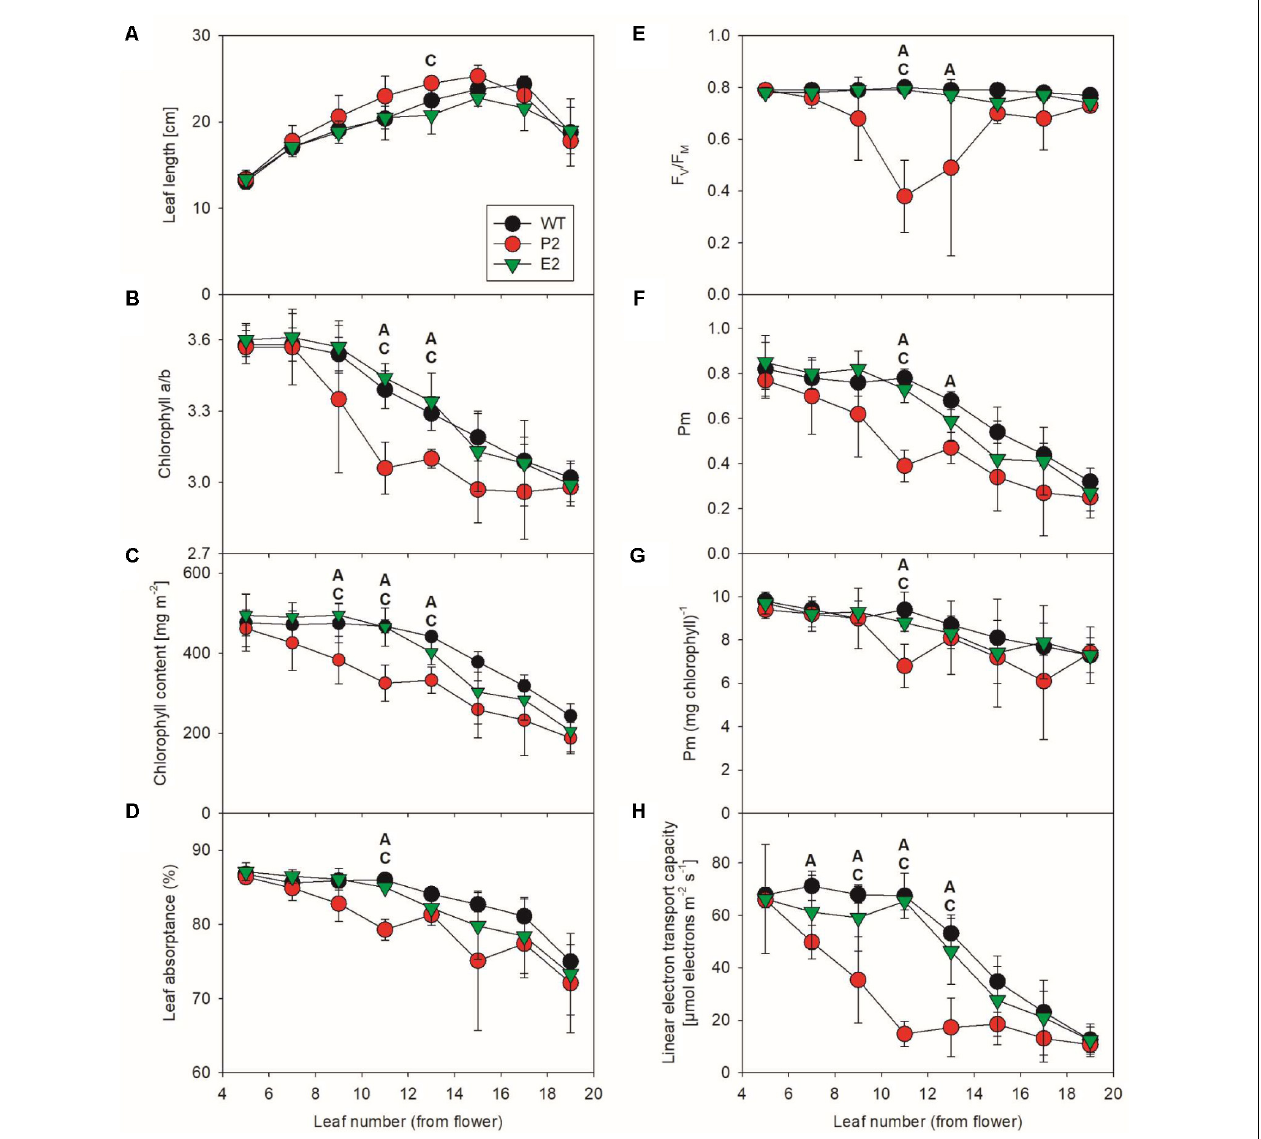
FIGURE 5 | Photosynthetic function in SIR co-suppression lines. Changes in leaf length (A) , chlorophyll a/b ratio (B) , total chlorophyll content per leaf area (C) , leaf absorptance (D) , the maximum quantum efficiency of PSII in the dark-adapted state (F V /F M , E ), the amount of redox-active PSI per leaf area (F) and per chlorophyll (G) , and in linear electron transport capacity (H) during leaf ontogenesis in tobacco. For each time point of the developmental series, an ANOVA was performed for the wild-type, the strongest (P2) and the weakest (E2) mutant line. Statistically significant differences between wild-type and P2 (indicated as “A”), wild-type and E2 (indicated as “B”), and between the two co-suppression lines (indicated as “C”) are shown ( P < 0.05).